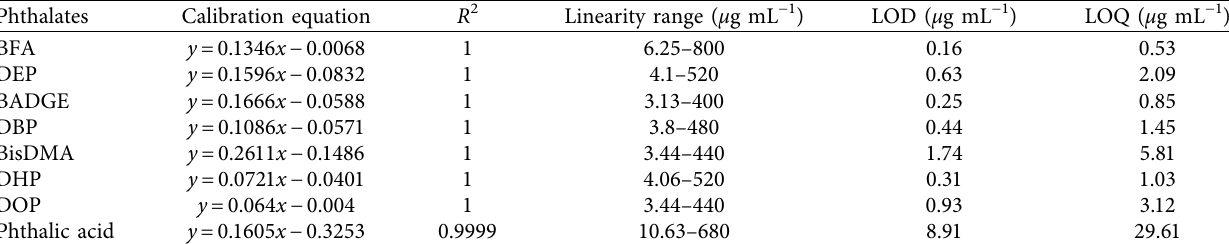
Figure 1: Chromatogram of the phthalate (DEP, DBP, DHP, DOP, and Phthalic acid) and bisphenol (BPA, BADGE, and BisDMA) standards. Chromatographic conditions: standard concentration (0.8mg mL − 1 ), acetonitrile as mobile phase A and water as mobile phase B, mobile phase gradient profile (where t refers to the time in minutes) of t 0 , A � 1.018, t 1 , A � 2.051, t 2 , A � 2.051, t 3 , A � 3.592, t 4 , A � 7.664, t 6 , A � 9.794, t 7 , A � 11.01, t 8 , A � 12.798, t 9 , A � 15.76, total flow rate of 1.0mL min − 1 , column temperature of 25 ° C, and injection volume of 5 µ L. Table 1: Analytical parameters of the proposal